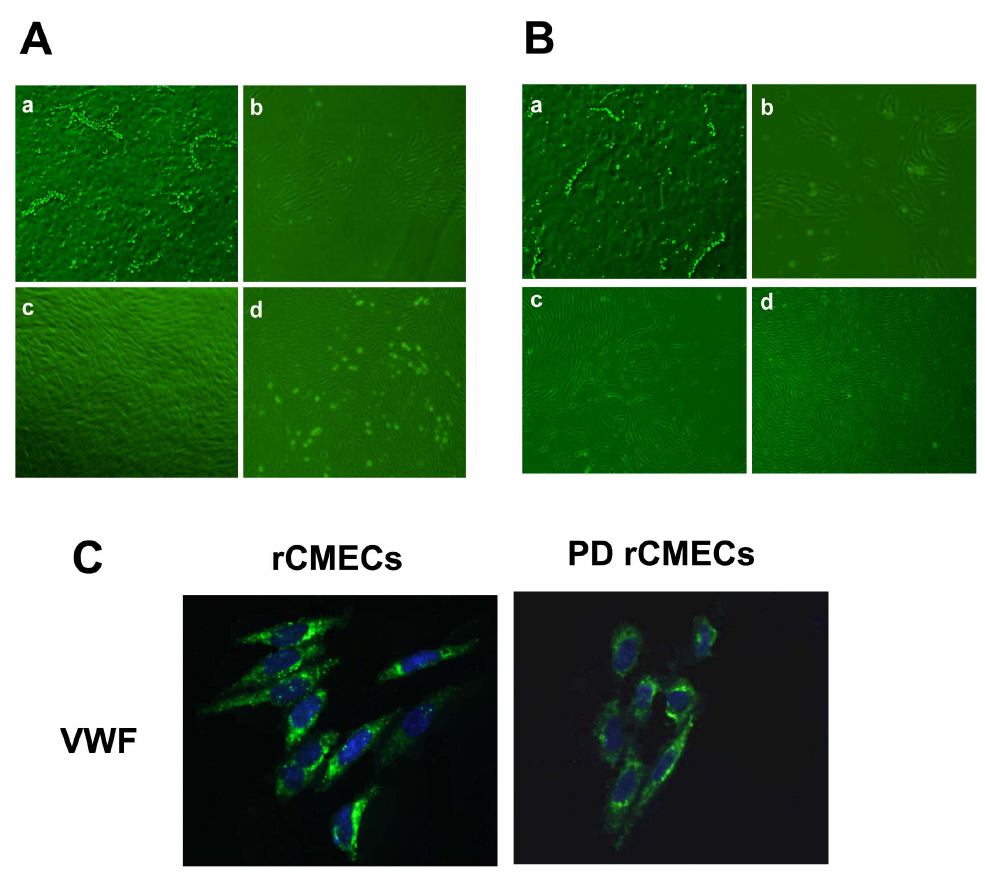
Figure 3. Phase photomicrograph and characterization of rCMECs primary culture by immunofluorescence microscopy. Phase- contrast micrographs of normal (A) and PD (B) rCMECs in primary culture 0 (a), 3 (b), 5 (c) and 7 (d) days after inoculation. In primary culture 3 days the initial outgrowth morphology of normal (Ab) and PD (Bb) rCMECs colonies were similar to an elongated swirling pattern. As the cultures matured and the cells in the colonies multiplied in primary culture 5 days, normal rCMECs (Ac) became elongated and grew in non-overlapping continuous monolayers, but similar states in PD rCMECs (Bc) have not yet been observed. In 7 days after inoculation the normal (Ad) and PD (Bd) rCMECs formed typical ‘‘classic cobblestone’’ morphology and appeared to contact-inhibition property when the monolayers were confluent. The time of PD rCMECs growing into confluent monolayers was longer than rCMECs in spite of cultured at approximate cell density. Panel C are the immunofluorescent images of rCMECs cultures probed for vWF (green) and DAPI nuclear stain (blue). Both normal and PD rCMECs express endothelial cells specific